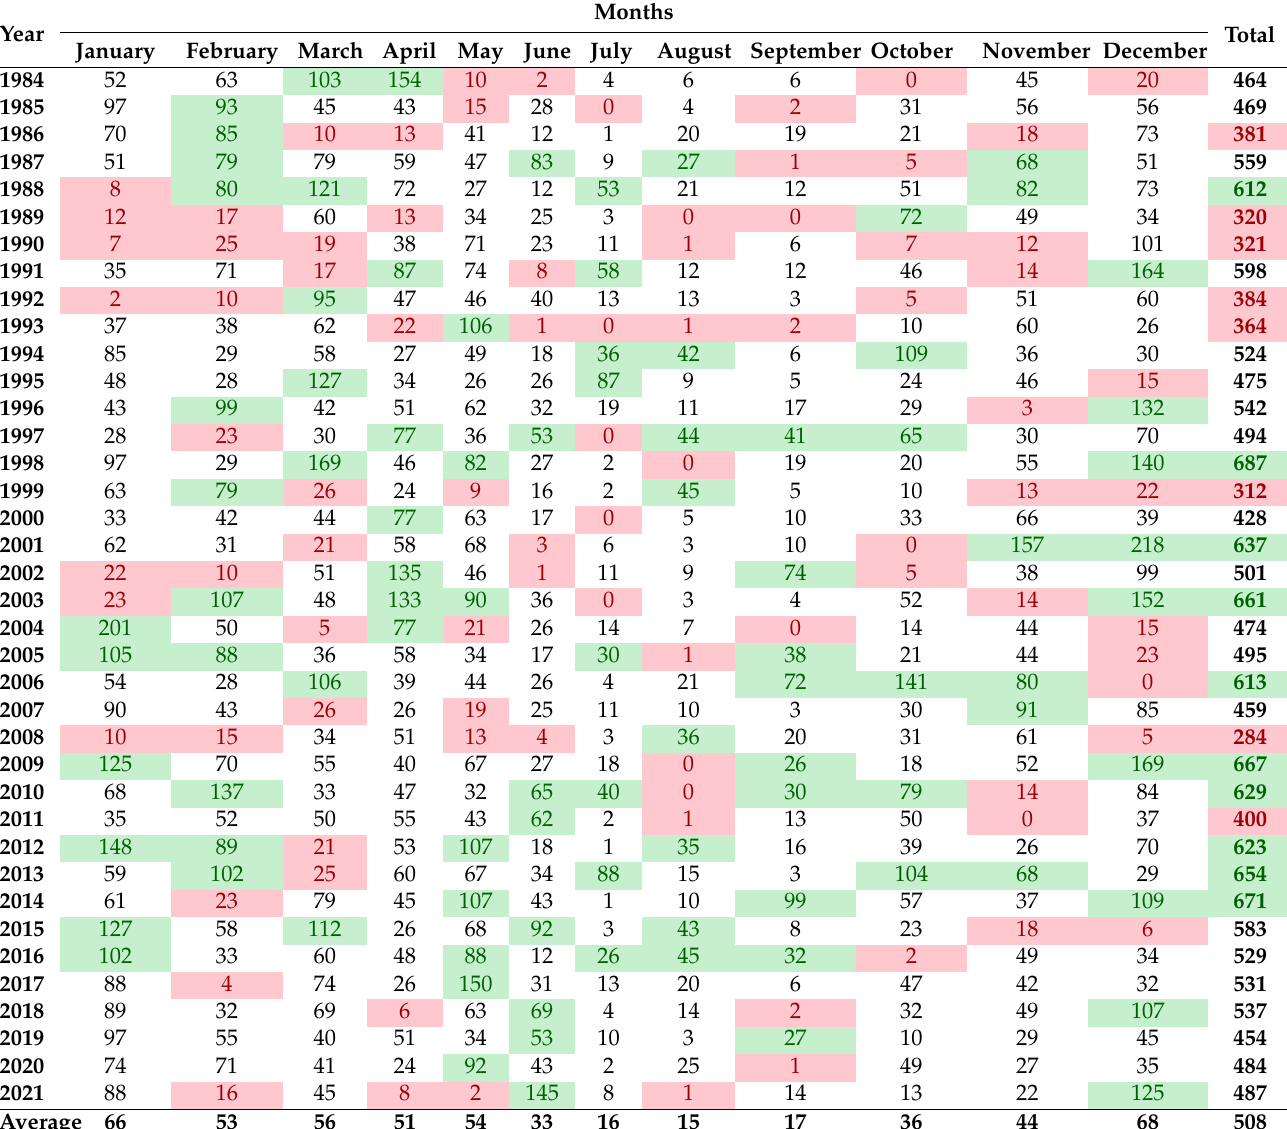
Red color indicates dry months and years, green color indicates wet months and years, and the white color indicates normal months and